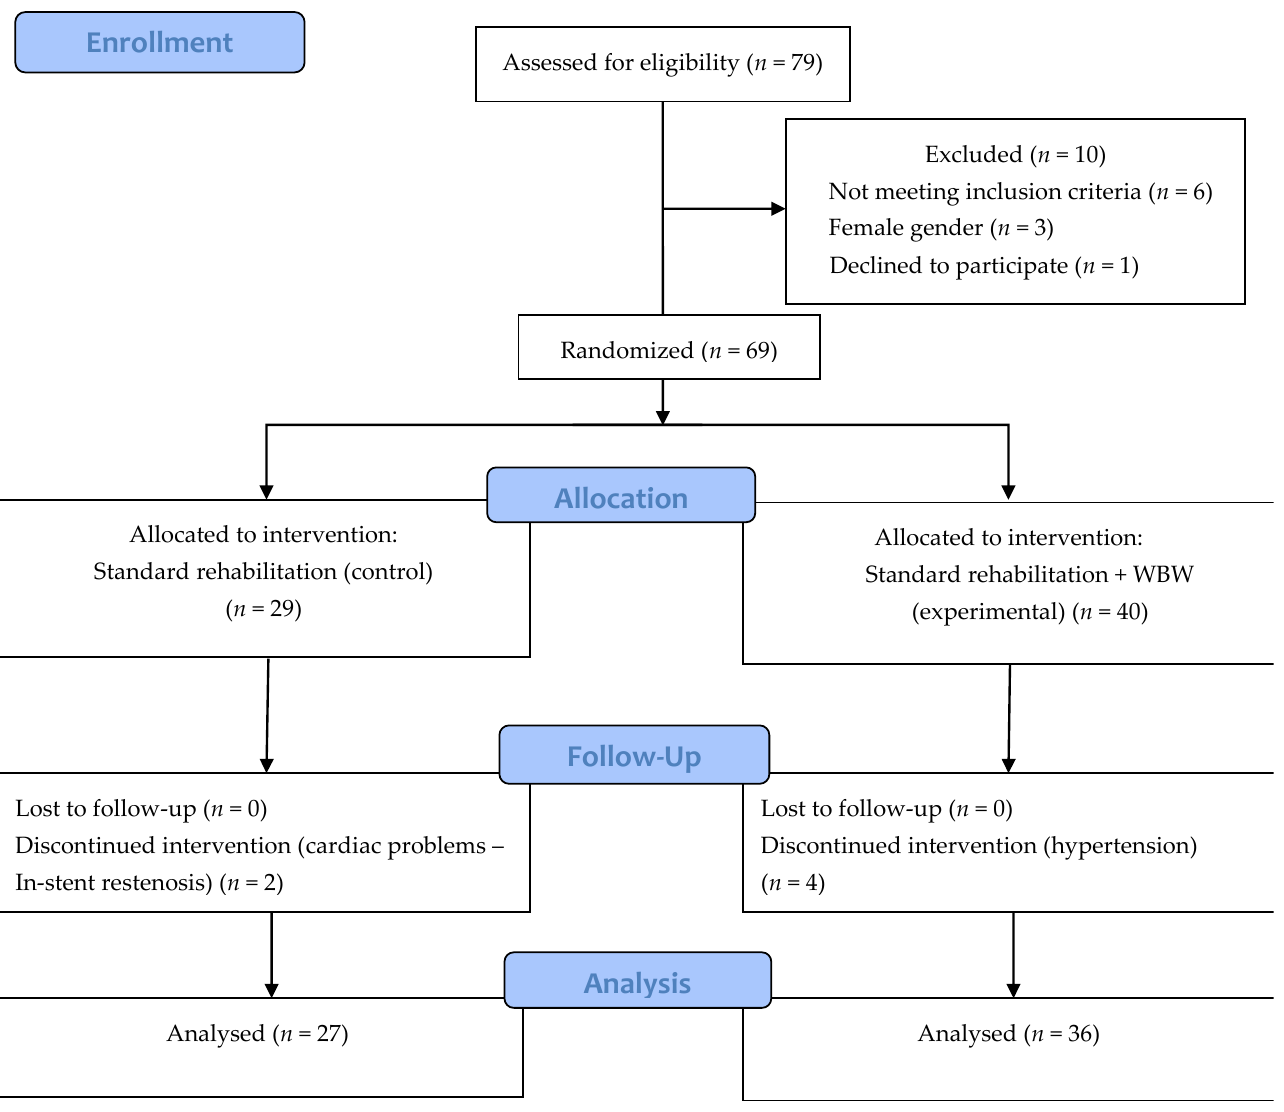
Figure 1. Flow diagram. * Too small number that could change results of statistical analysis.